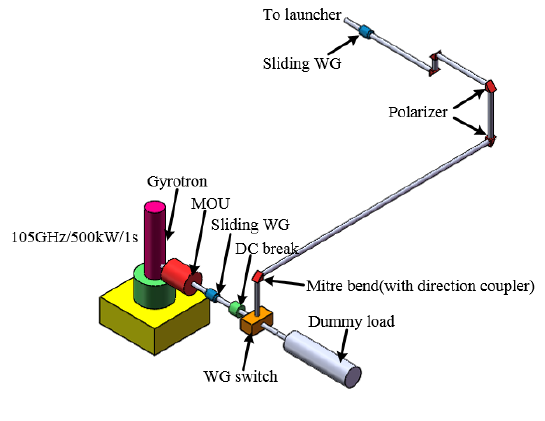
Fig. 1 . Layout of a transmission